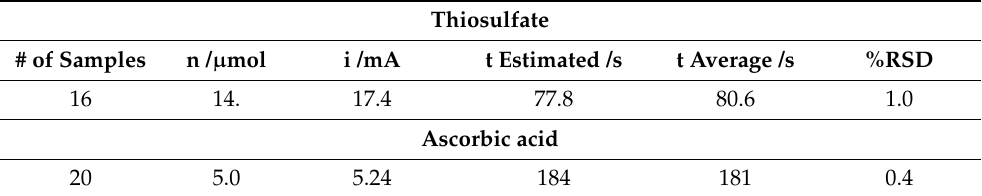
Table 1. A summary of the results for the iodometric titrations by using the two-compartment cell. Thiosulfate # of Samples n / µ mol i